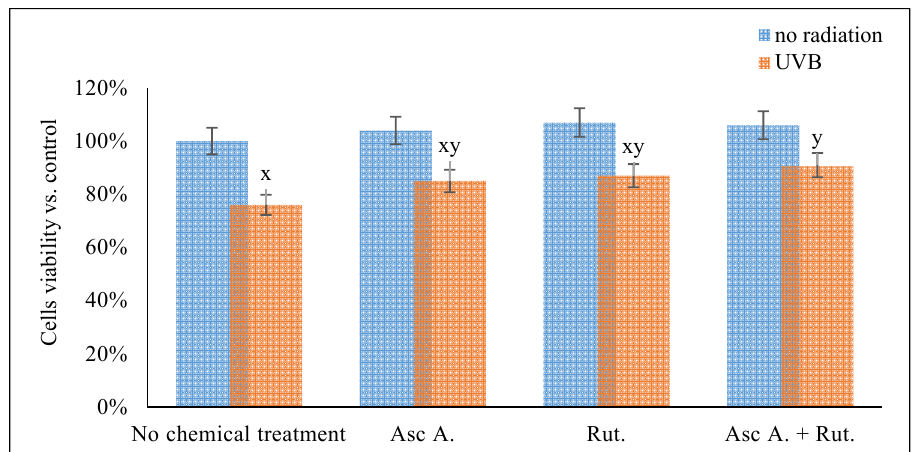
Figure 1. The viability of the 3D cultured fibroblasts exposed to UVB irradiation (200 mJ/cm 2 ) and treated with ascorbic acid [100 μ M] and/or rutin [25 μ M]. Abbreviations: Asc, ascorbic acid; Rut, rutin; Ctr, control. Mean values ± SD of three independent experiments are presented. x, statistically significant differences vs. non-irradiated group without chemical treatment, p < 0.05; y, statistically significant differences vs. non-irradiated group, p < 0.05.